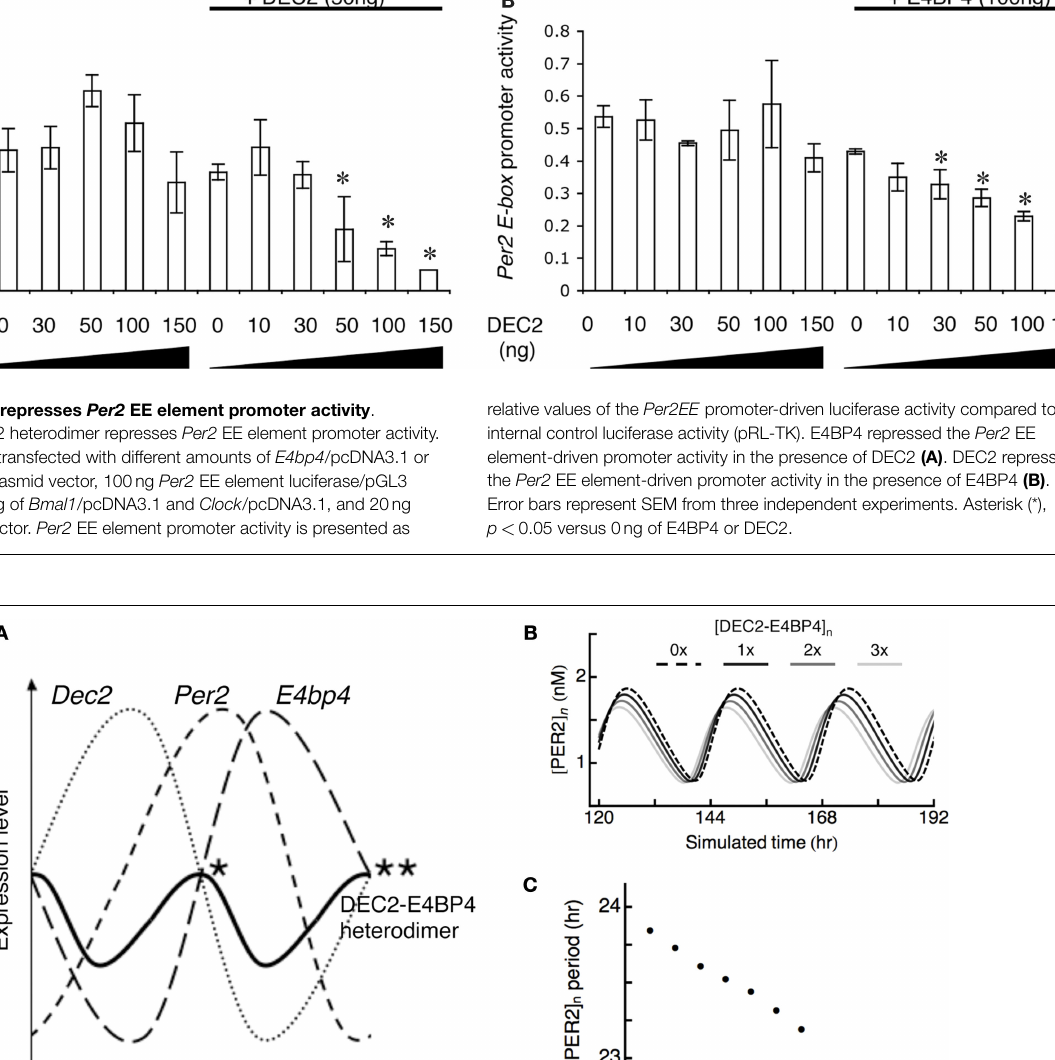
FIGURE 4 | Possible roles of DEC2–E4BP4 heterodimer in the interlocked Per2 oscillation . (A) Phases of clock gene cycling in SCN. Dec2 expression cycling is opposite to E4bp4 expression cycling in the SCN (23, 28). Two peaks of DEC2–E4BP4 heterodimer levels in the SCN should be at subjective dusk (*) and dawn (**), at which DEC2 and E4BP4 expression levels are equal. Per2 expression levels are high at subjective dusk and trough at subjective dawn in SCN (11, 12). DEC2–E4BP4 heterodimer represses Per2 expression levels to determine time points of peak and trough of Per2 expression cycling. (B) Theoretical model of PER2 protein expression cycling